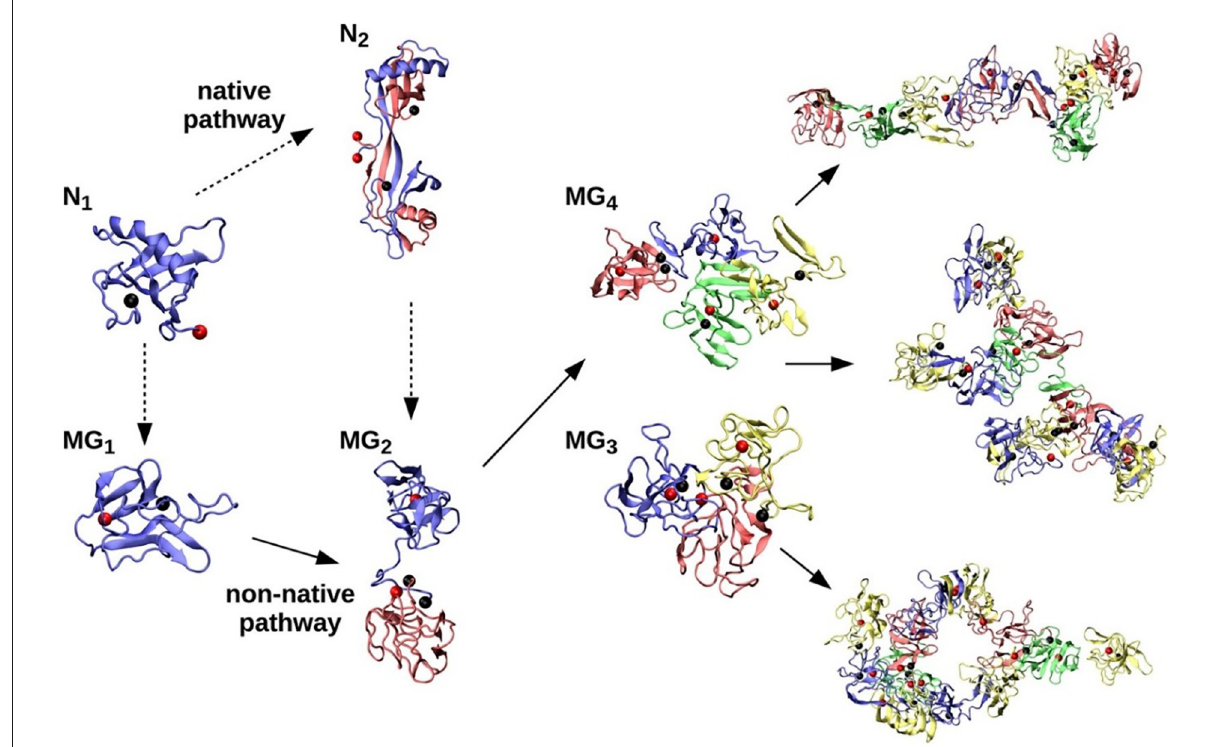
FIGURE2 Native (N) and non-native (MG) assembly pathways of stefin B-var2. Under partially denatured conditions, the native monomer (N 1 ) forms a stable domain-swapped dimer (N 2 ). Native monomers (N 1 ) and dimers (N 2 ) are denatured (dashed arrows) under amyloidogenic conditions, resulting in MG monomer (MG 1 ) and MG dimer (MG 2 ) populations that further assemble into MG trimers (MG 3 ), MG tetramers (MG 4 ), and larger oligomers of various morphologies (elongated octamer, branched undecamer, and annular dodecamer, from top right to bottom right, respectively). Reproduced from Zganec et al.